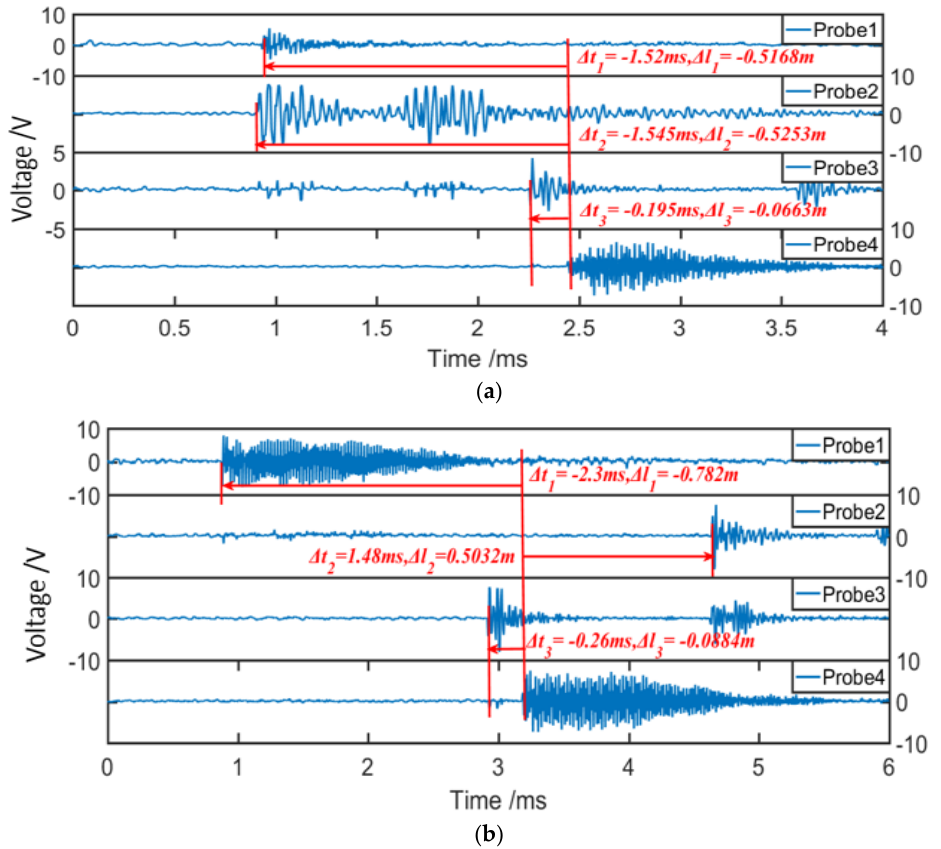
Figure 4. The time-domain responses of four MEMS-on-fiber sensors when the ultrasonic signal appears at the setting positions of ( a ) (1.5, 1.5, 0.5) and ( b ) (1.5, 0.5, 0.5).